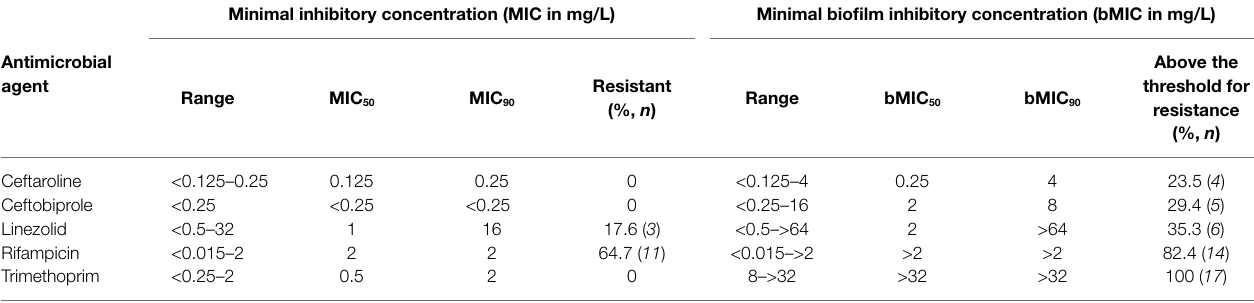
TABLE 1 | Overall susceptibility results for the 17 CF MRSA strains that were classified as strongly adherent/strong biofilm producers according to the Biofilm Ring Test ® assay.